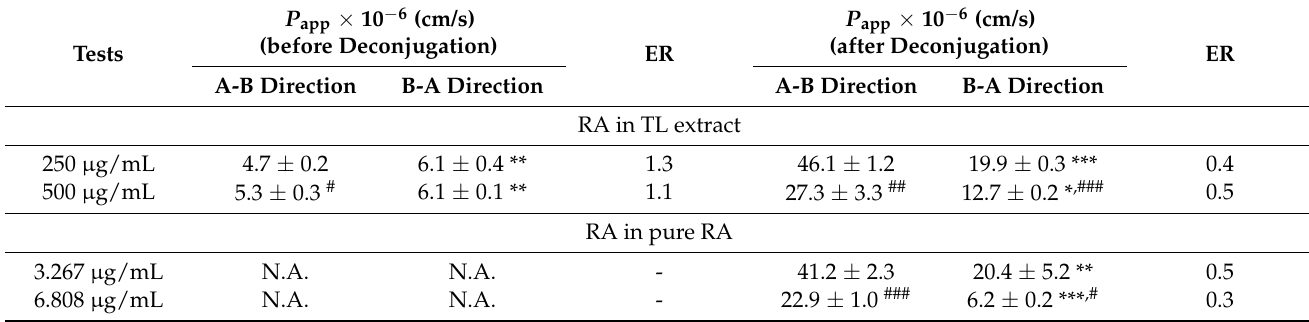
Table 2. The P app of RA in TL extracts and pure RA before and after deconjugation.